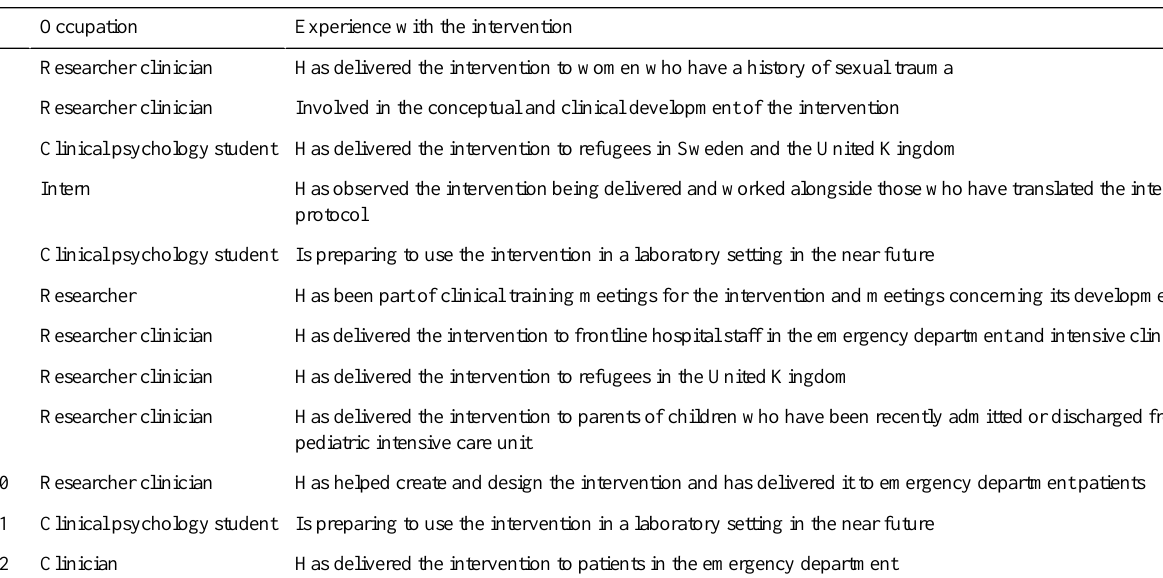
Table 1. Participant occupation and relevant experience with the intervention. Experience with the